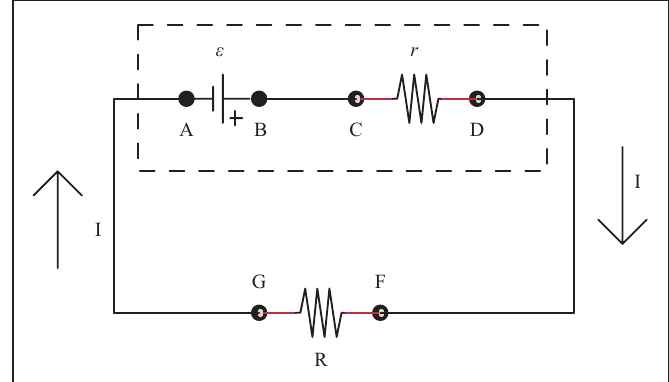
Fig. 1. Circuit diagram of a battery of emf Ɛ , of internal resistance r , connecting to an external resistance